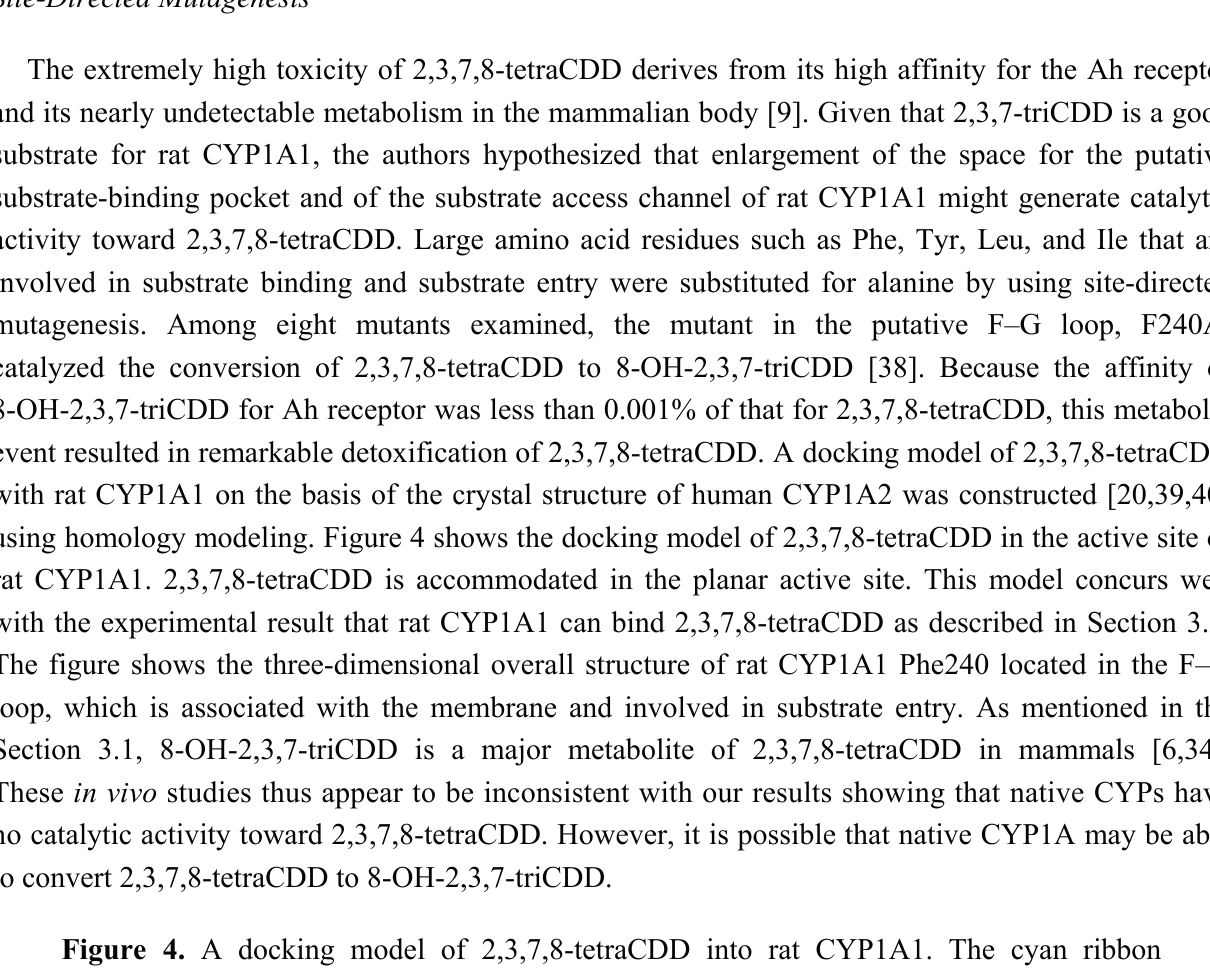
Figure 4. A docking model of 2,3,7,8-tetraCDD into rat CYP1A1. The cyan ribbon represents the F–G loop. The yellow shaded region is the substrate-binding